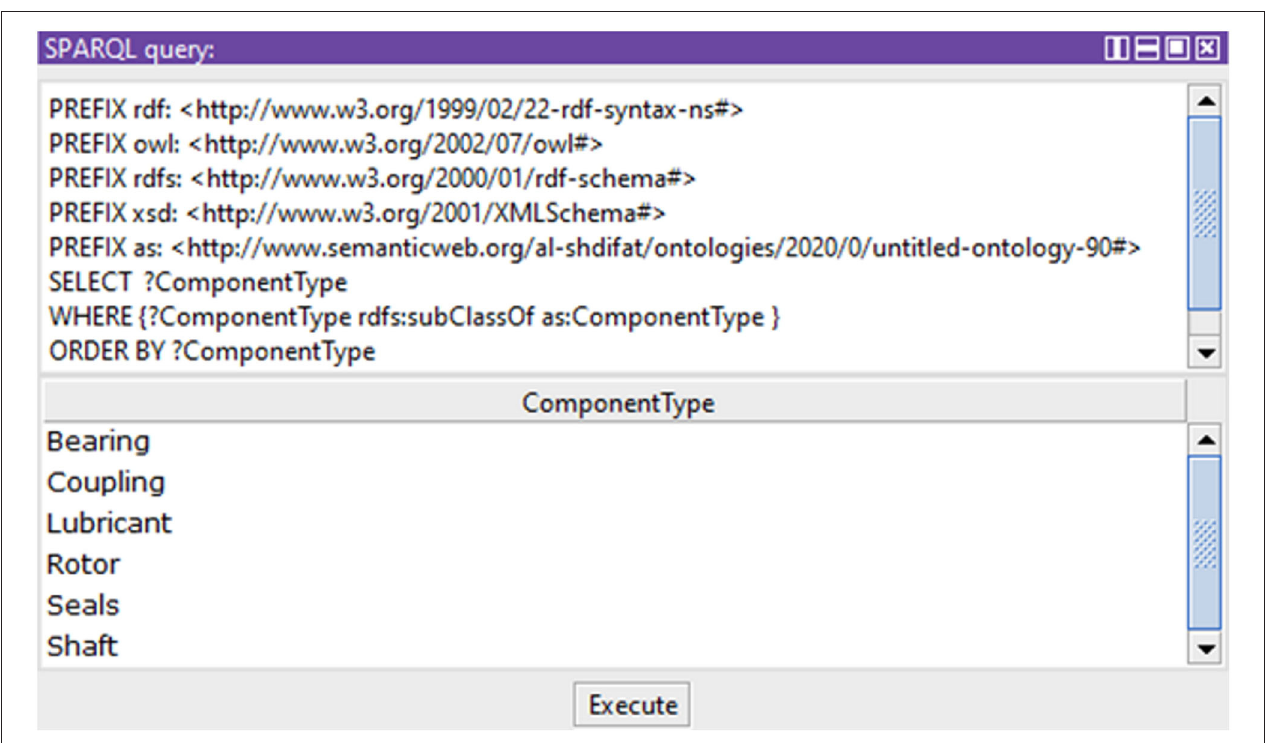
FIGURE 4 | Query result to identify the main